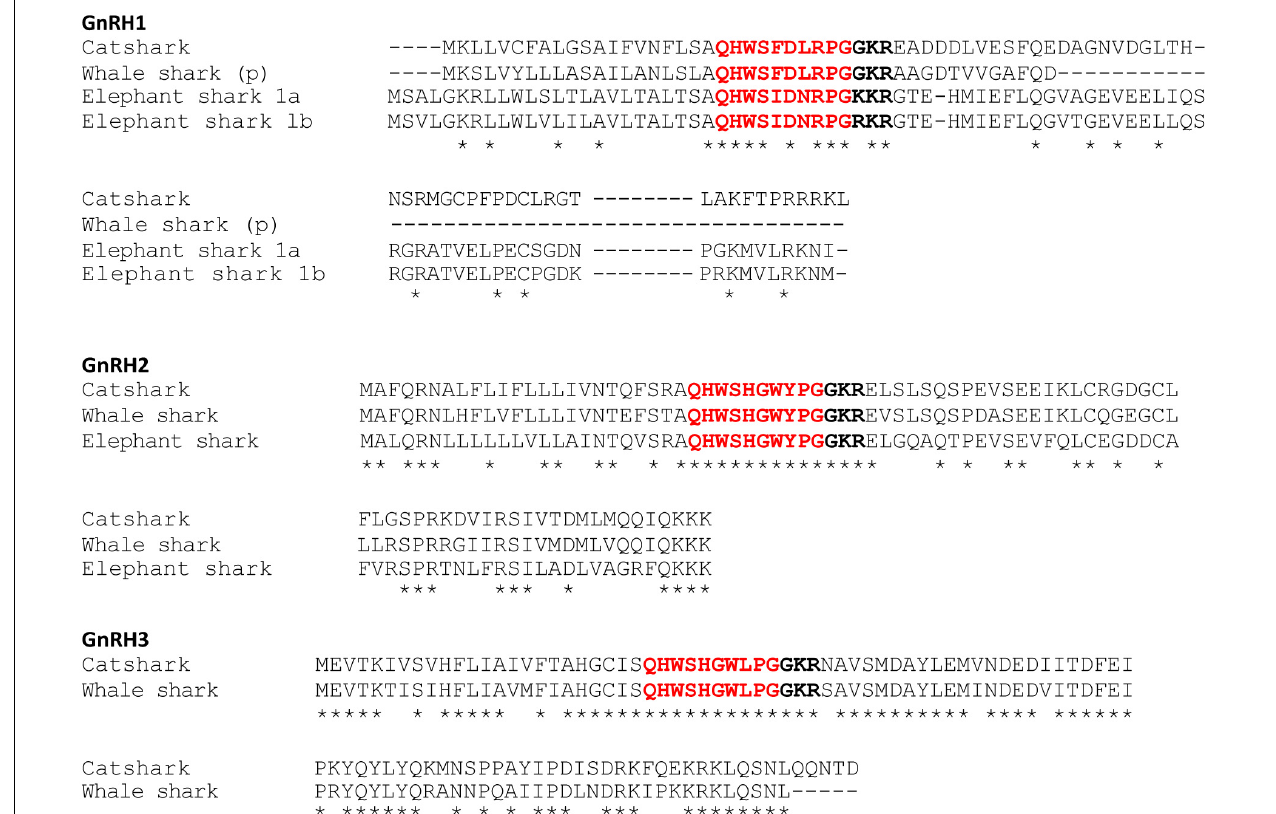
FIGURE 2 | Alignment of the amino acid sequences of prepro-GnRHs characterized in the present study. Note that whale shark prepro-GnRH1 sequence is restricted to that encoded by the first exon. ∗ Denotes conserved residues. Putative bioactive peptides are in red. Potential cleavage sites are in bold. (p), partial